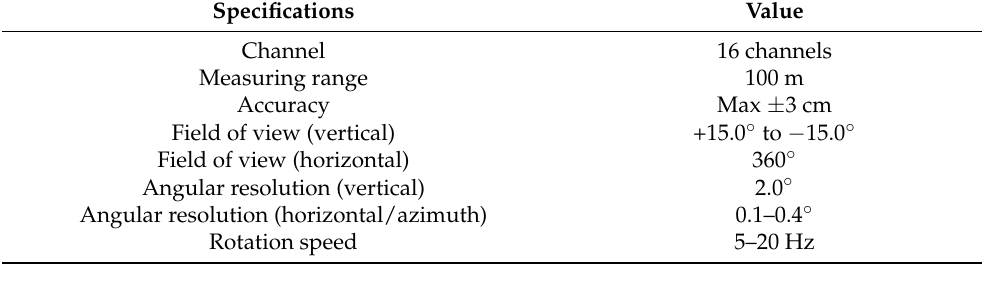
Table 4. Velodyne VLP-16 specifications.